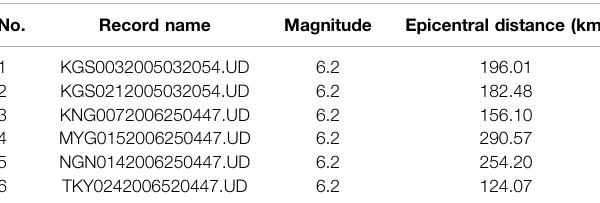
TABLE 4 | Information about the misclassi fi ed earthquakes (false negative) for the testing